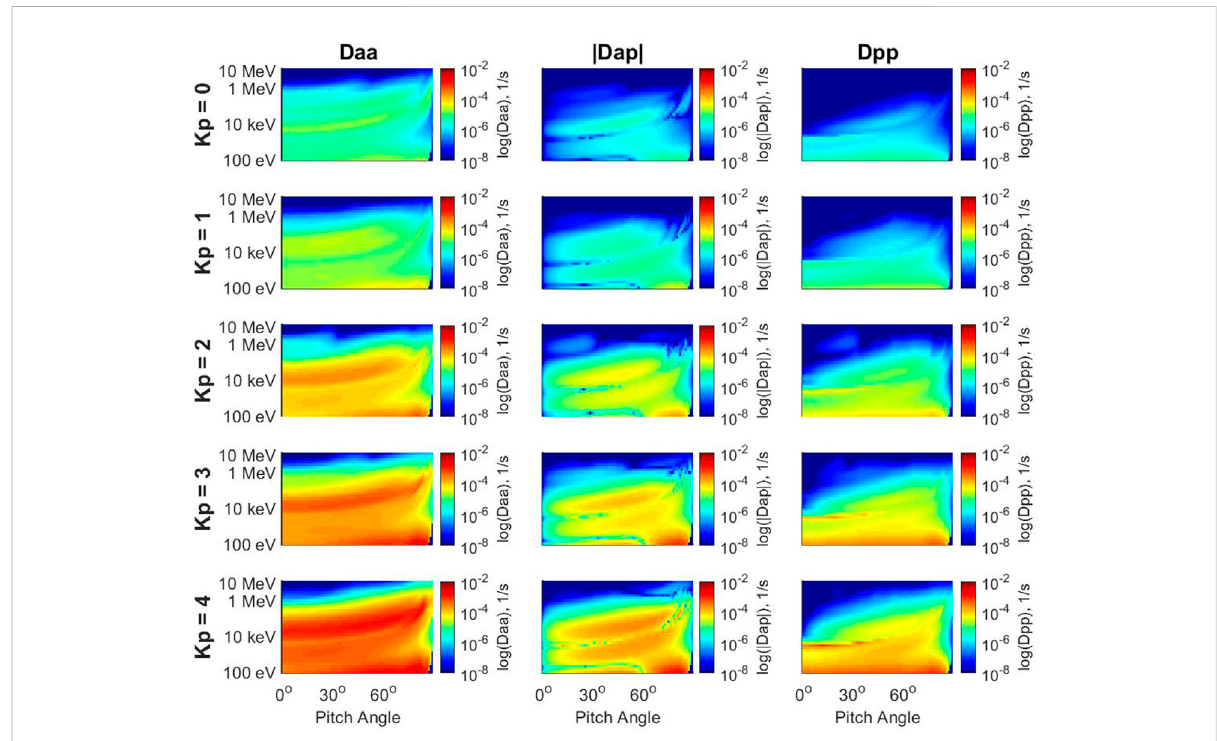
FIGURE 1 Diffusion coef fi cients binned by Kp index for L = 5, and MLT from 6:00 to 07:00. Note the color scale and axes are the same in each plot. The energies range from 100 eV up to 10 MeV, and the equatorial pitch angle ranges from 0.5 ° to 89 °